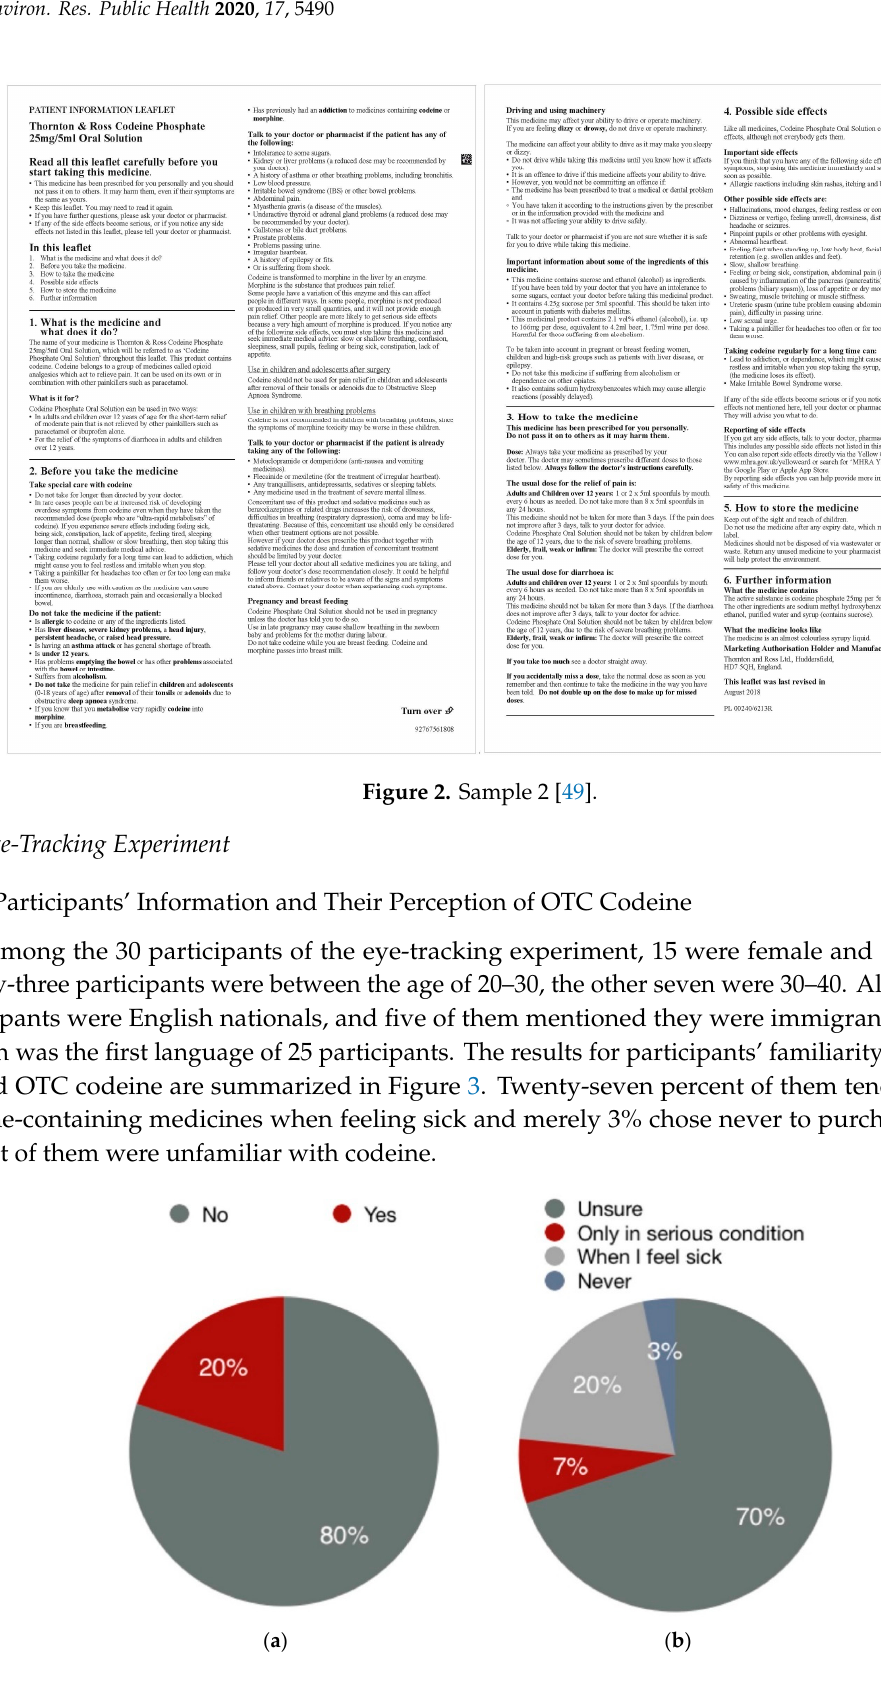
Figure 3. The results of two questions from the pre-experimental survey: ( a ) Are you familiar with opioid analgesic or codeine-containing medicines? ( b ) Please identify how many times the warning sign of addiction was mentioned in this